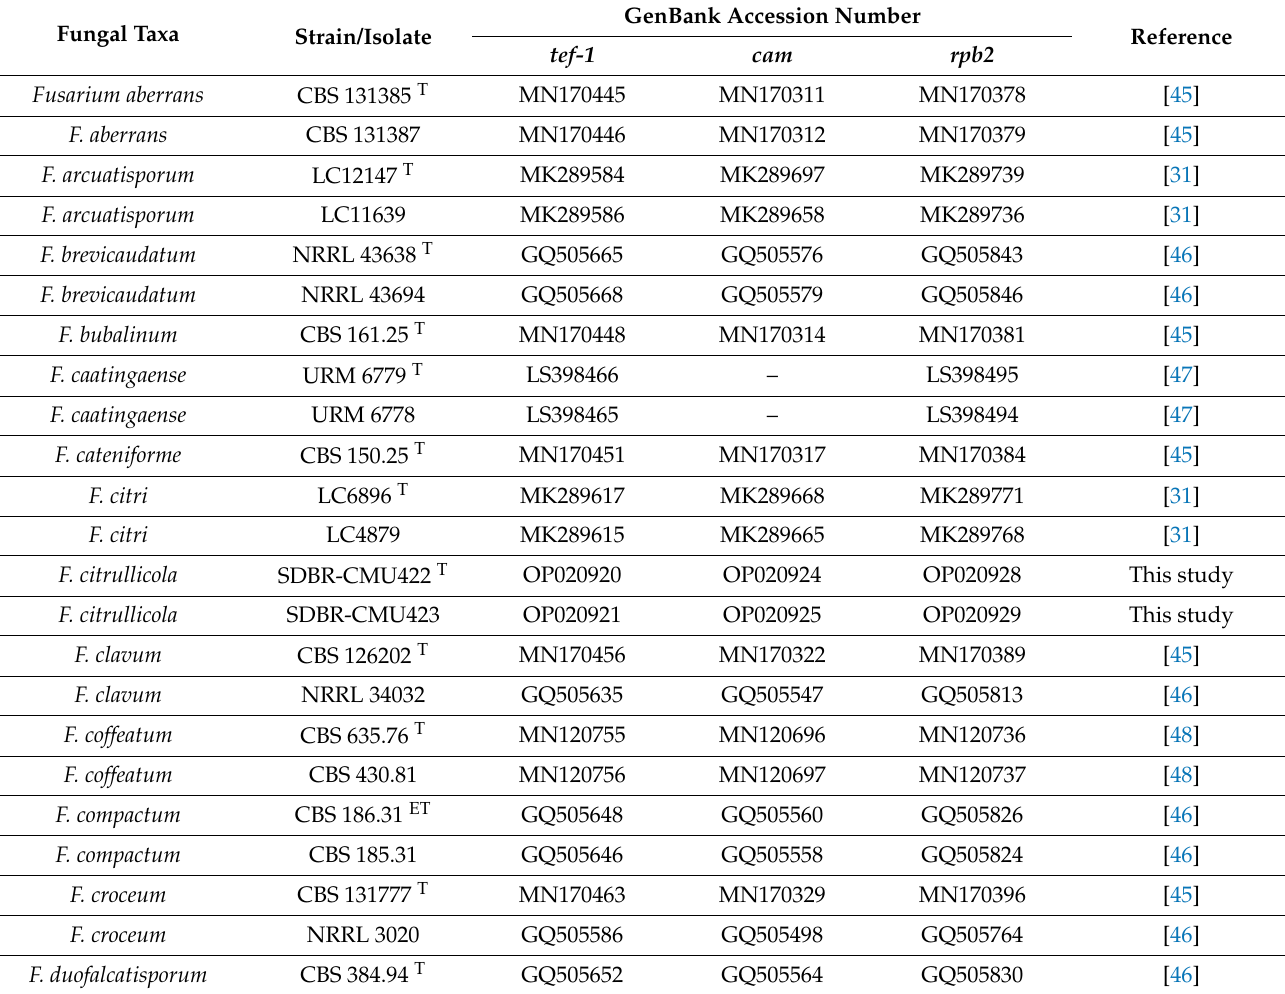
Table 2. Details of sequences used in the molecular phylogenetic